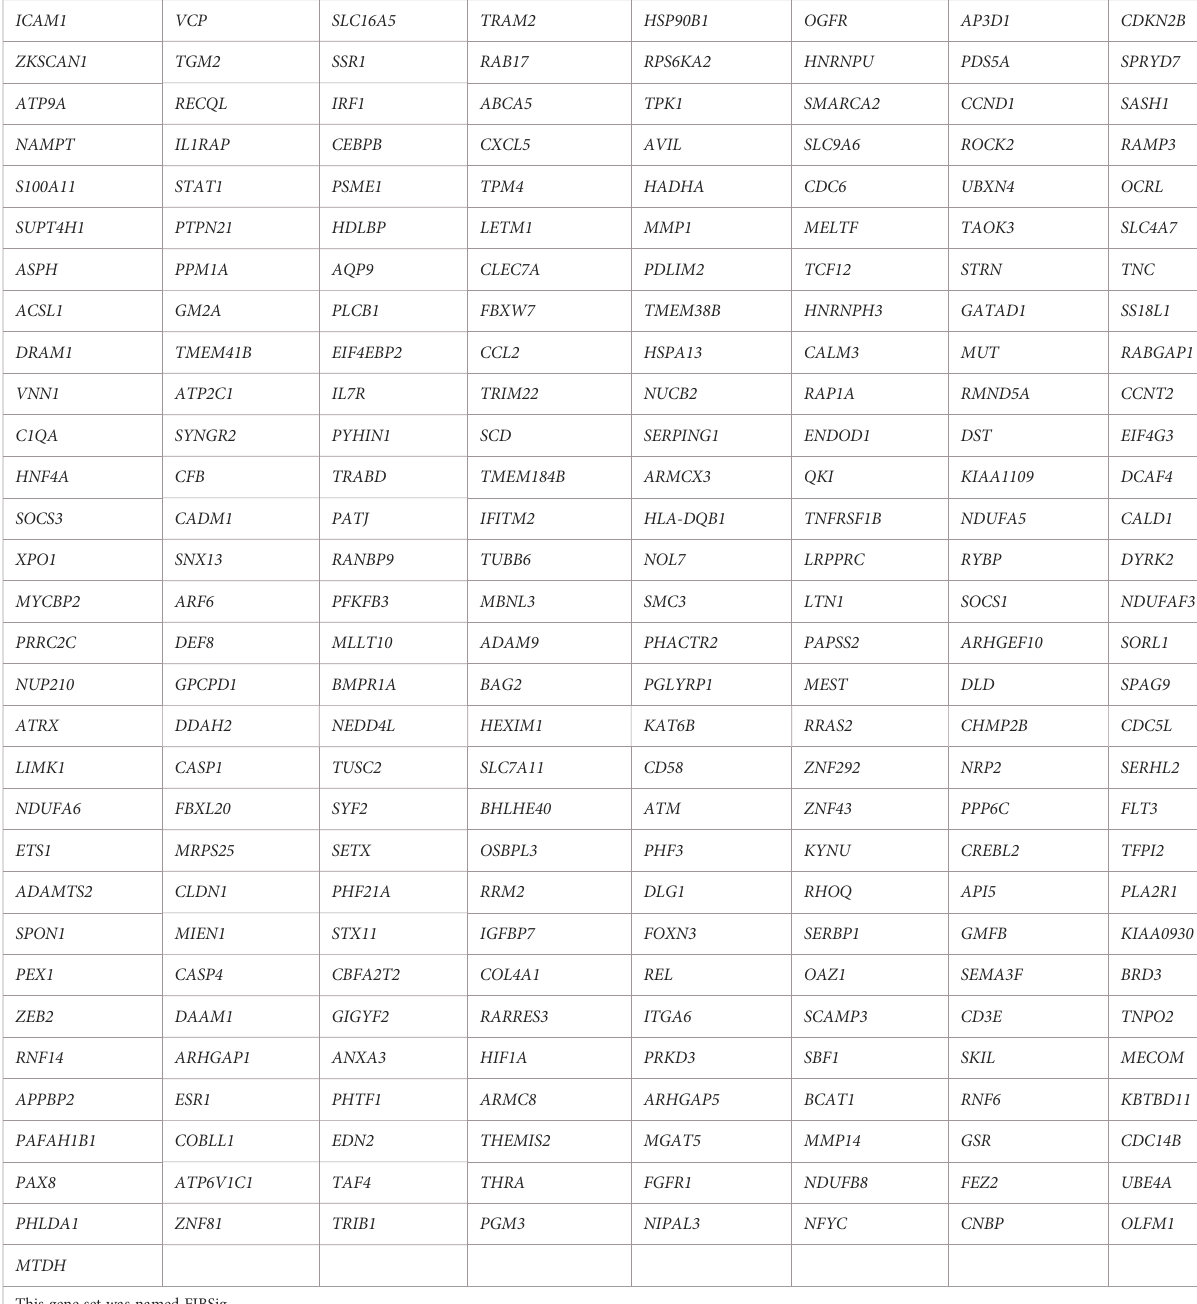
TABLE 2 Transcriptomic signature of 241 genes commonly dysregulated in all fi brotic disorders under study.